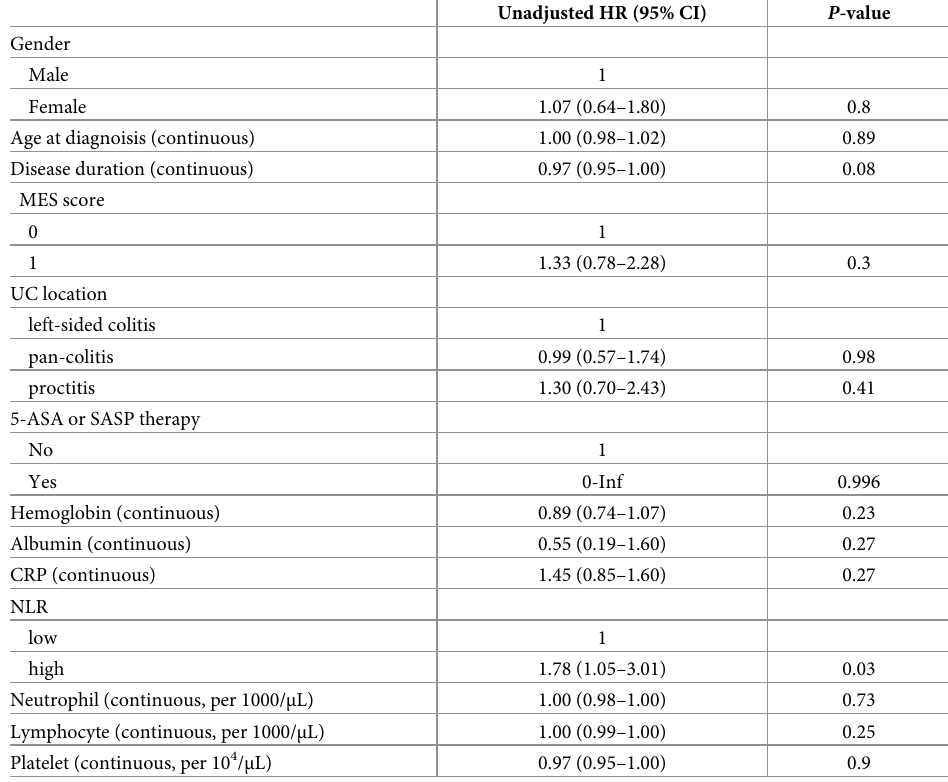
Table 3. Cox regression analysis of risk for clinical relapse.